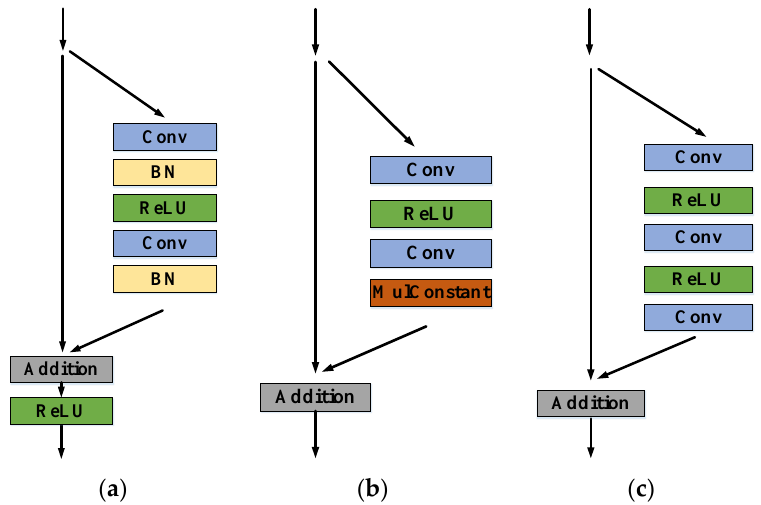
Figure 1. Comparison of residual blocks in the original ResNet, enhanced deep super-resolution network (EDSR), and our model. ( a ) Original ResNet residual block; ( b ) EDSR residual block; ( c ) Our proposed residual block.